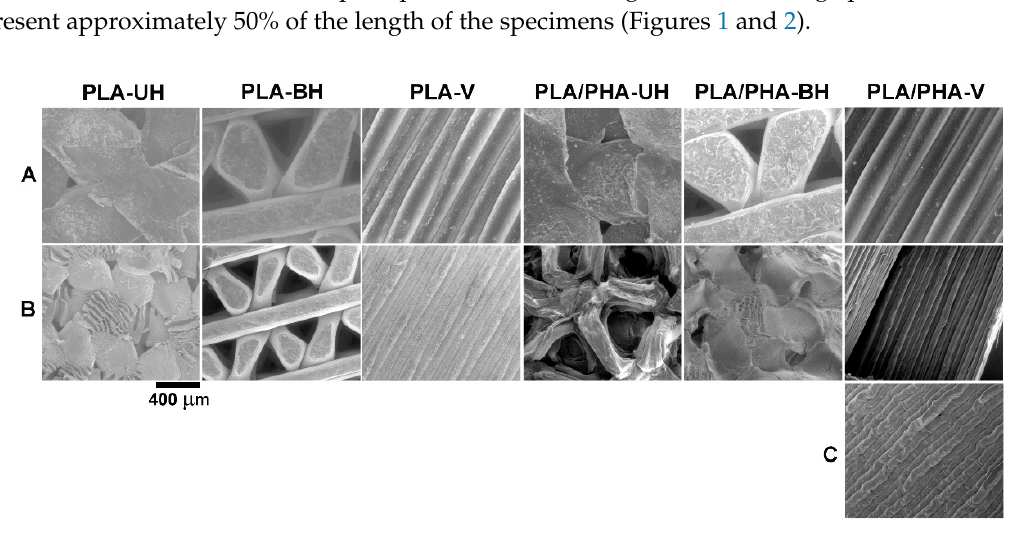
Figure 2. Selected SEM micrographs (200×) of the upper (UH) and underside (BH) layers of PLA and PLA/PHA dumbbell-shaped specimens obtained by 3D printing in horizontal (H) and vertical (V) directions before ( A ) and after 70 days of hydrolytic degradation test at 70 °C ( B ) the whole specimens after degradation, ( C ) cut in half specimens after degradation).